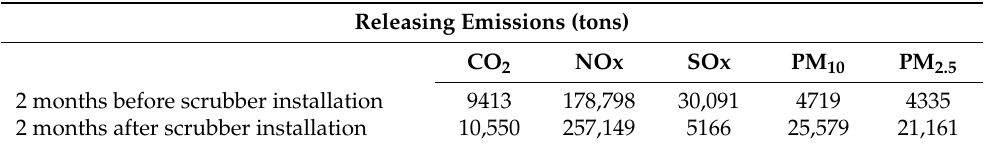
Table 6. Comparison of releasing emissions before/after scrubber